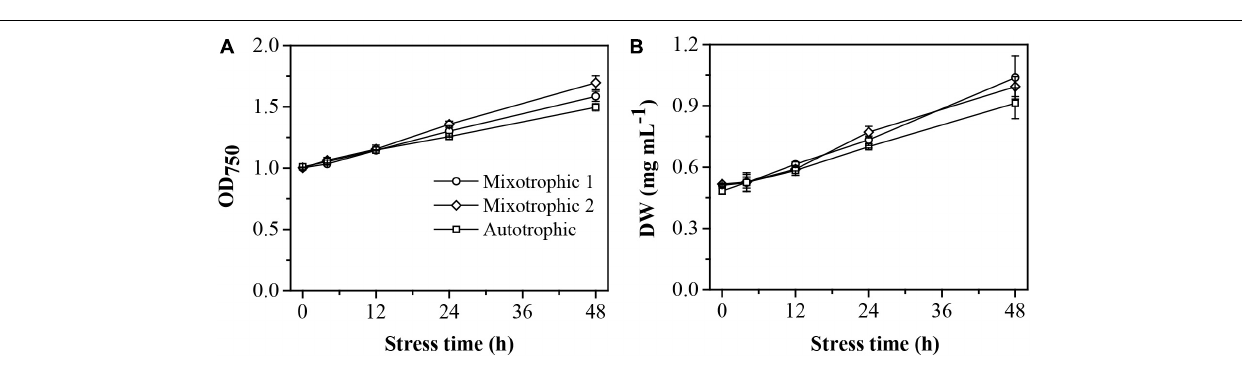
FIGURE 2 | Time course of changes in growth performance of C. reinhardtii BAFJ5 cultures under three carbon supply regimes over 48 h of HL-N. The carbon supply regimes for mixotrophic 1, mixotrophic 2, and autotrophic were 17 mM acetate and 2% CO 2 (v/v), 17 mM acetate and ambient 0.04% CO 2 (v/v), and 2% CO 2 (v/v), respectively. Values are the means of three independent replicates ± SD ( n = 3). OD 750 , optical density; DW, dry weight